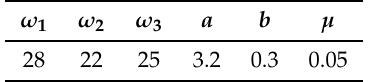
Table 2. Parameter settings of the system.